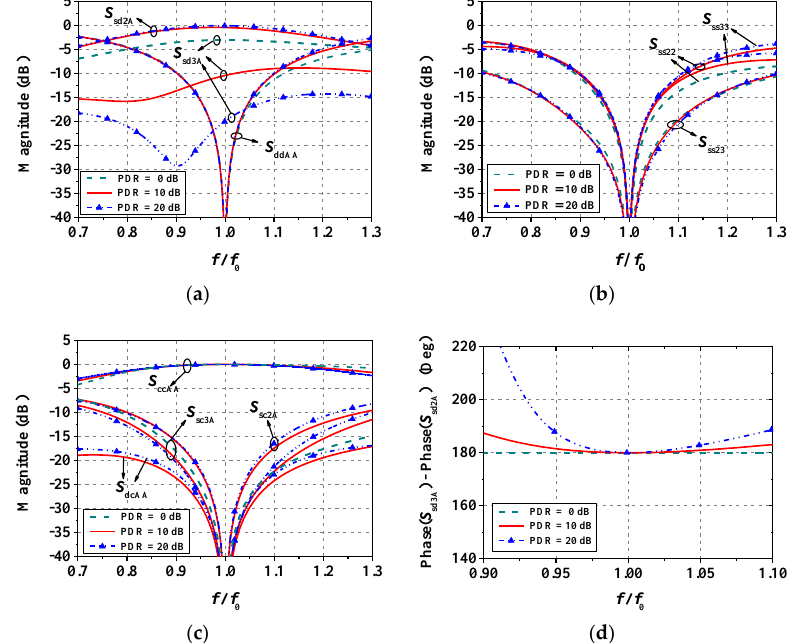
Figure 4. Mixed scattering parameters for three cases of PDR. ( a ) S sd and S dd . ( b ) Output ports isolation and return loss. ( c ) S sc , S cc , and S dc . ( d ) Phase di ff erence between output